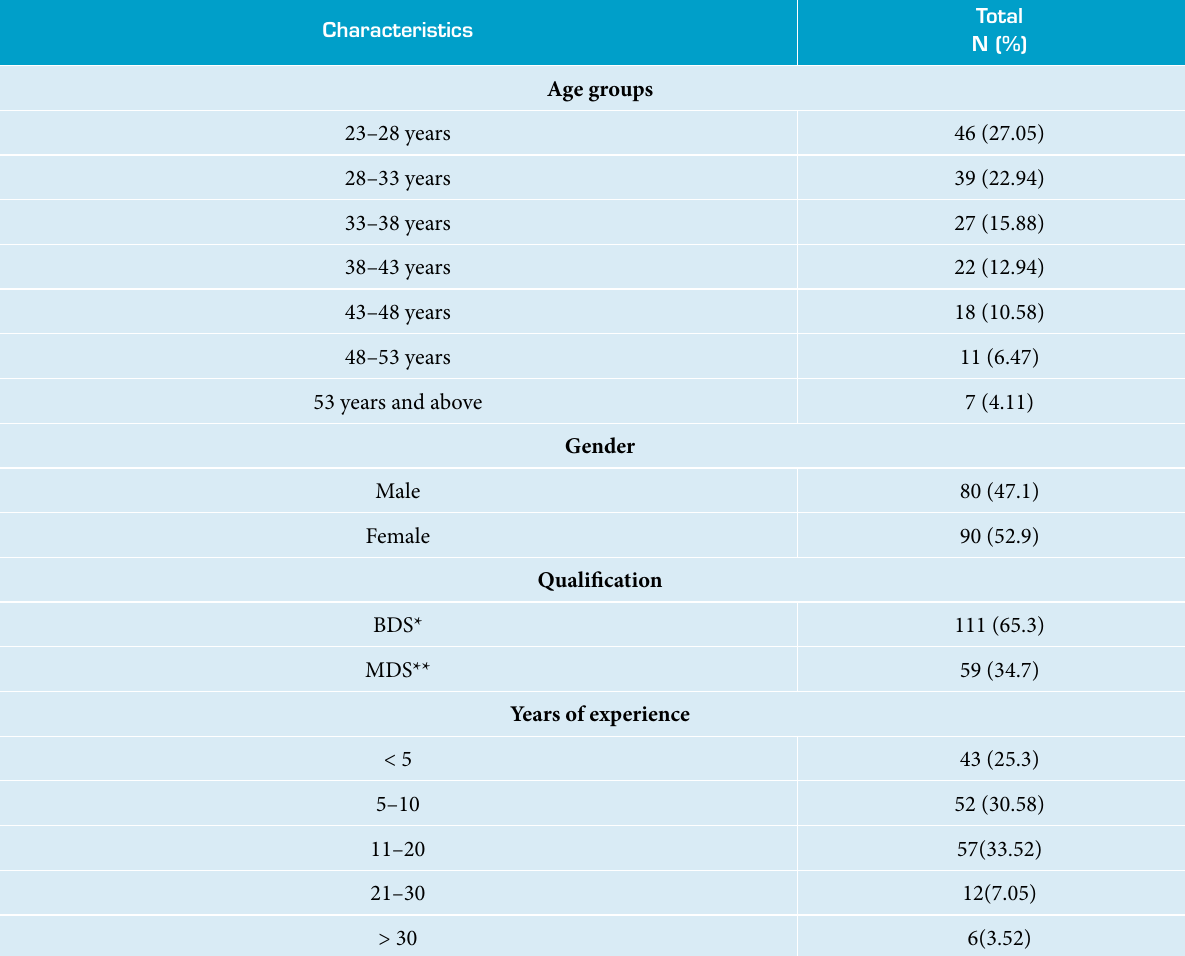
Table 1. Distribution of study participants according to age, gender, qualification and year of experience (n =